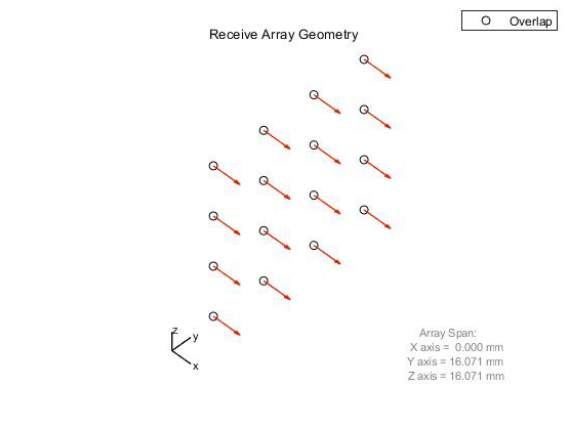
Fig. 8. UPA geometry at MS